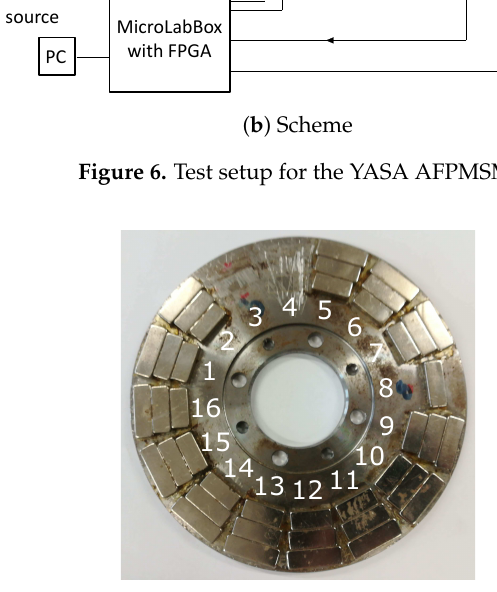
Figure 7. Faulty rotor disc with partial demagnetization: the complete third and fourth magnet, and a part of the eighth magnet are